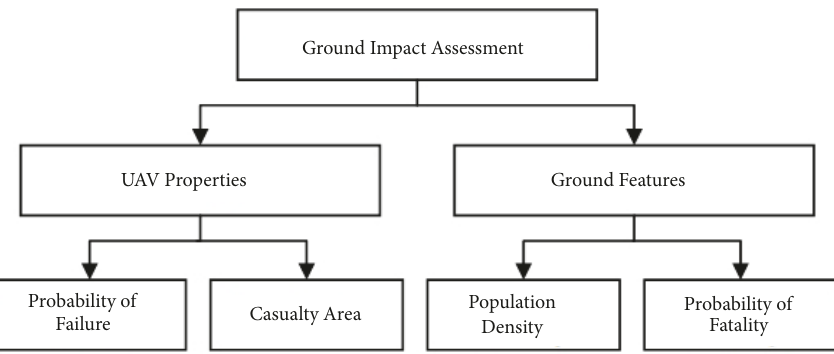
Figure 1: Problem description of ground impact